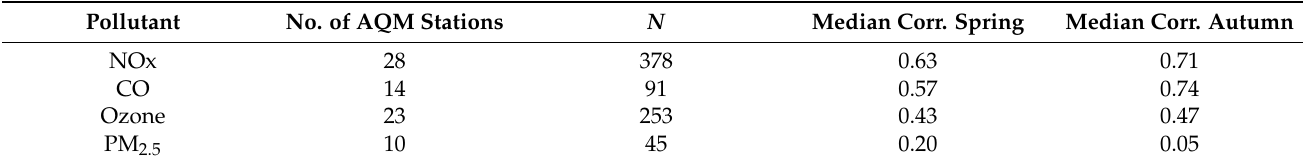
Table 1. Medians of the correlations between the DST effects observed at different AQM station pairs. The distribution of the correlations for each pollutant contains the correlations between all the combinations of AQM station pairs ( N ) that experienced peak traffic volumes of at least 200 cars or 20 trucks per hour.